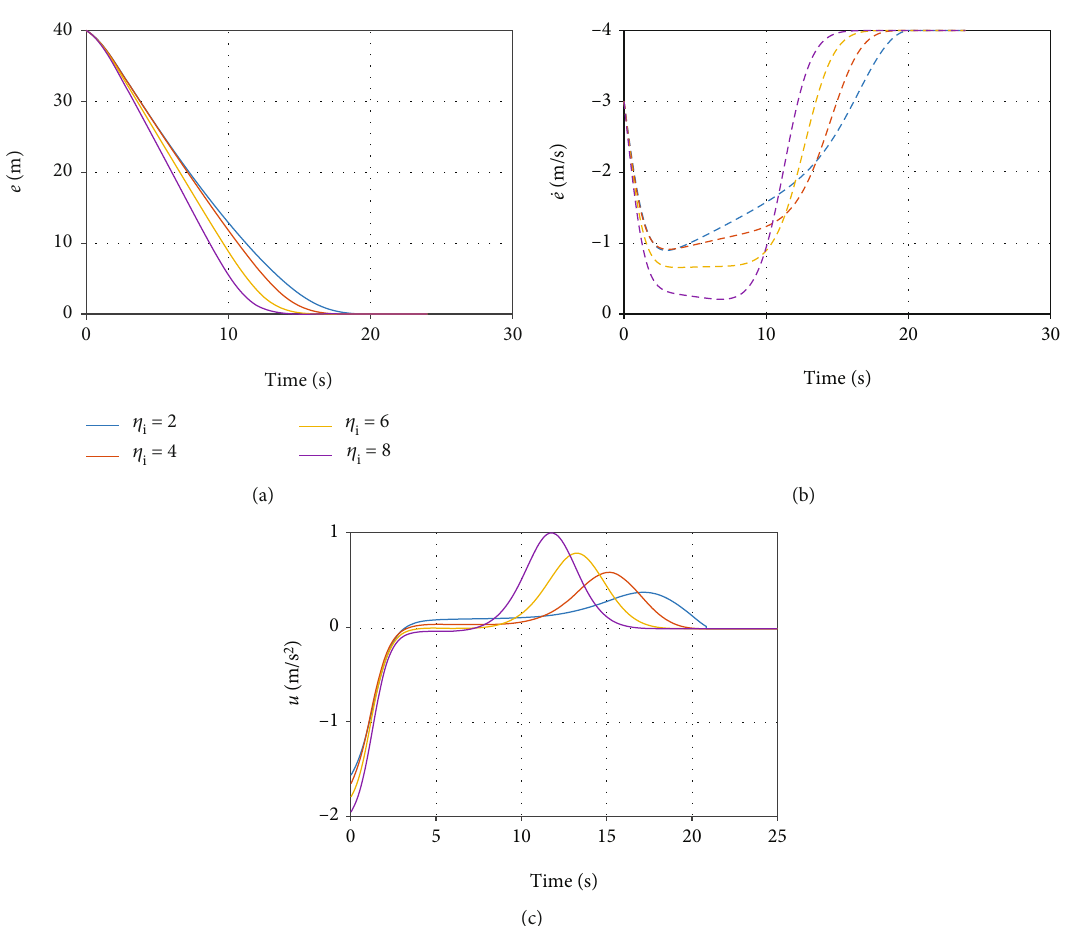
= 40 , _ e = − 1 , and t = 20 s. The 0 0 f